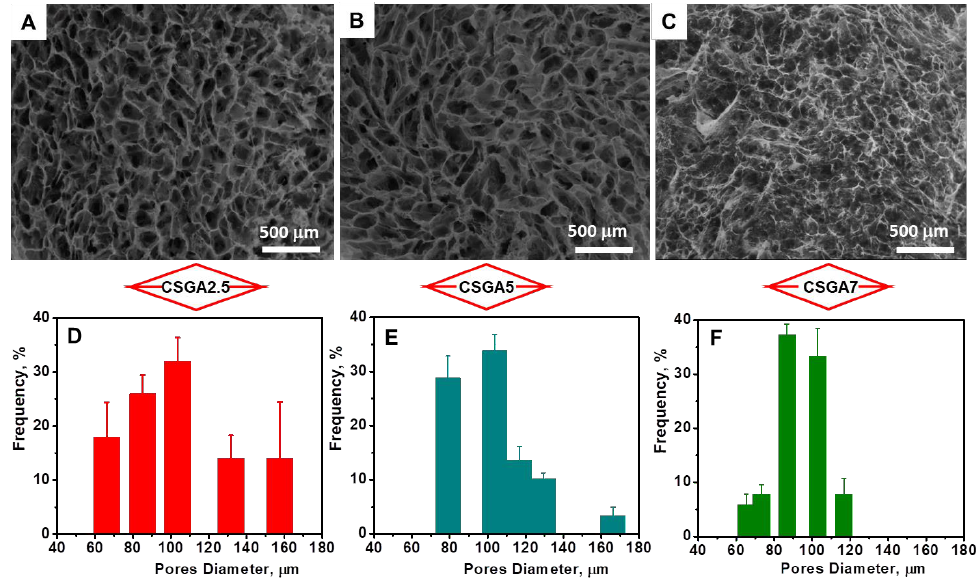
Figure 2. SEM micrographs and pore distribution diagrams of the CSGA2.5 ( A , D ), CSGA5 ( B , E ), and CSGA7 ( C , F ) cryogels.